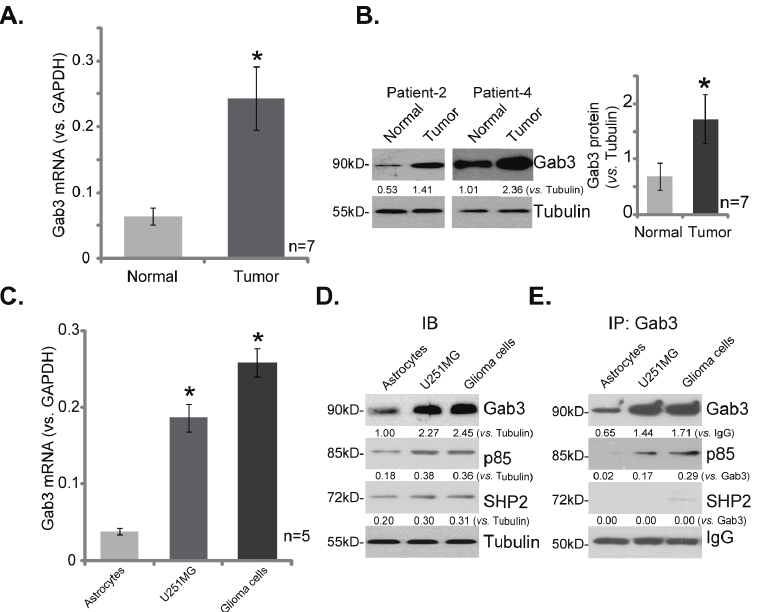
Fig 1. Gab3 overexpression in human glioma tissues and glioma cells. Gab3 mRNA and protein expressionin describedtissues and cell lines were detected by qRT-PCR assay (A and C) and Western blottingassay (B and D), respectively.SHP2 and p85 expressions were also tested (D). Gab3 association with p85 or SHP2 was tested by immunoprecipitation (IP) assay (E). (A and B) n = 7 means seven sets of tissues. (C) n = 5 means five replicatewells. The intensity of each band was normalized to the corresponding loadingcontrol or indicatedprotein. Data were presented as mean ± SD. * p < 0.05 vs. “Normal” tissues/